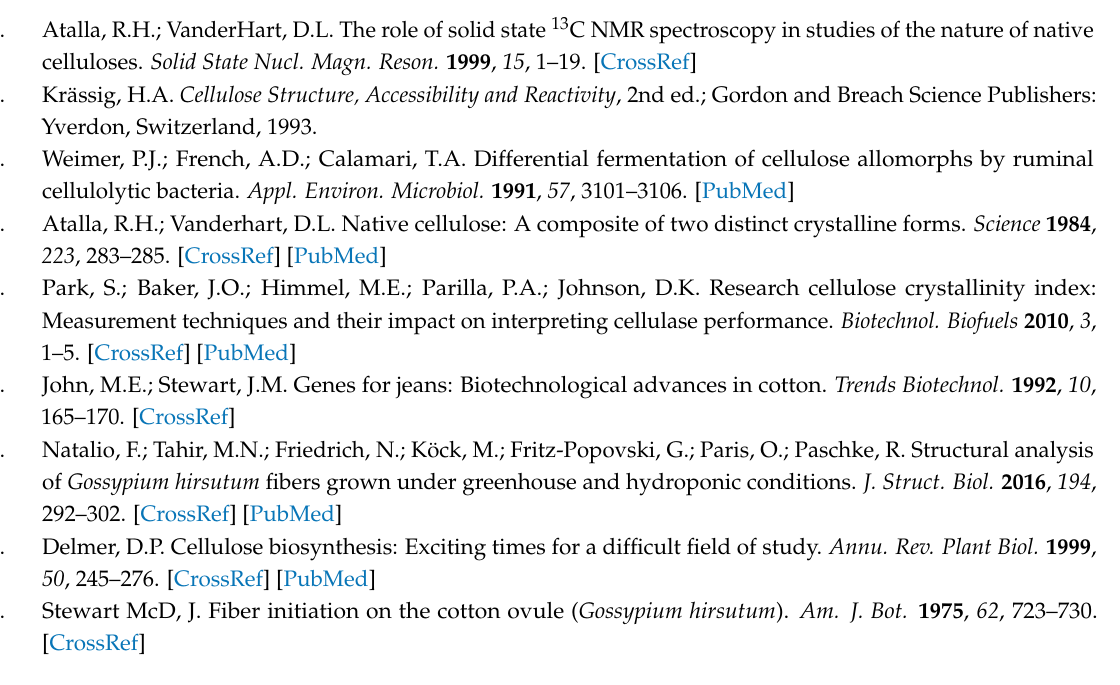
Figure S1: First derivative of the thermal profiles of raw/washed G. hirsutum fibers harvested at different stages of development (10, 14, 17, 20, 36 and 51 dpa) obtained from Figure. 4a. Figure S2: Representative scanning electron microscope images of fibers taken at (a) 17dpa and (b) 20 dpa (days post-anthesis) showing a spherical features; (c) higher magnification of spherical features. The electron accumulation suggests an organic nature. The square represents the area where the chemical analysis was carried out; (d) representative spectra obtained for the chemical elemental analysis of the spherical features showing the presence of high concentration of potassium and confirming the organic nature of these